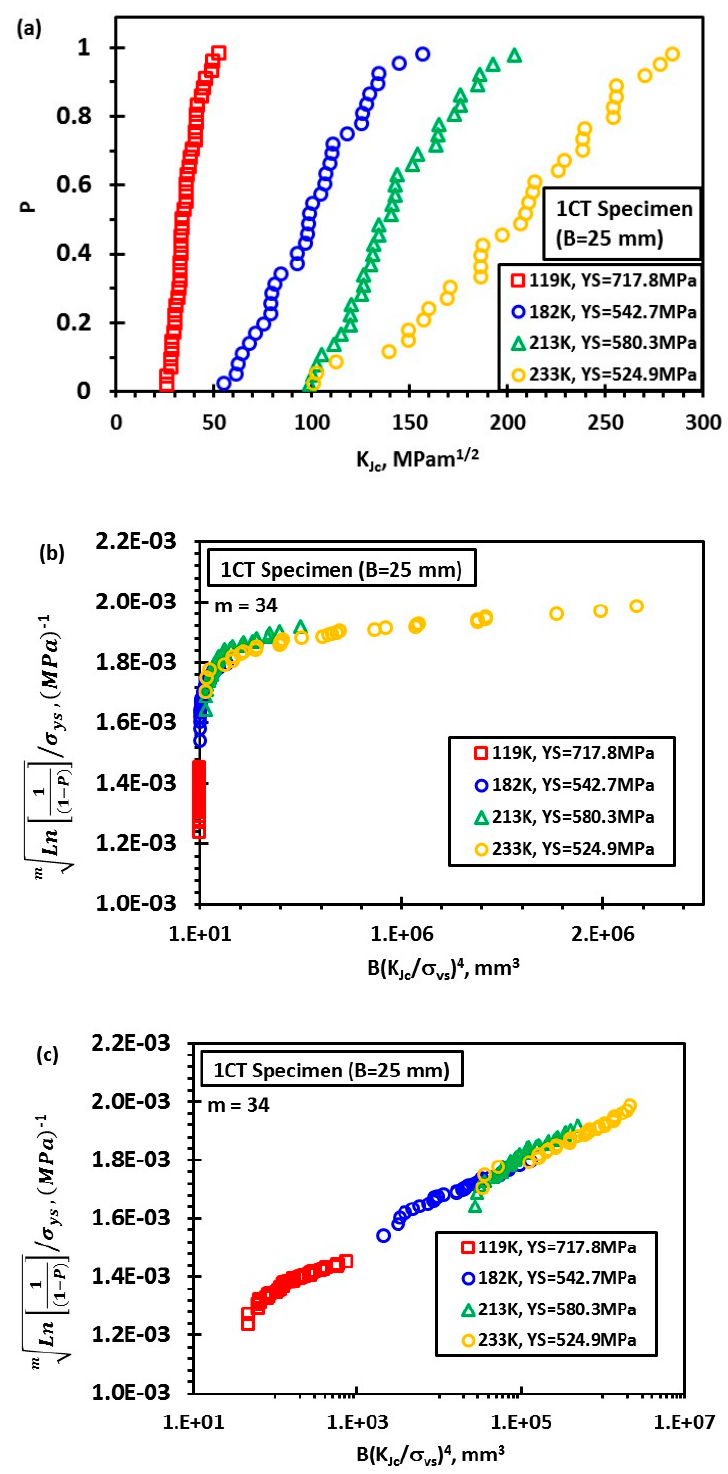
Figure 2. Fracture toughness of steel DIN 22NiMoCr37 measured by 1CT specimens: Raw data [27] ( a ); the correlation between m logarithmic scale ( c